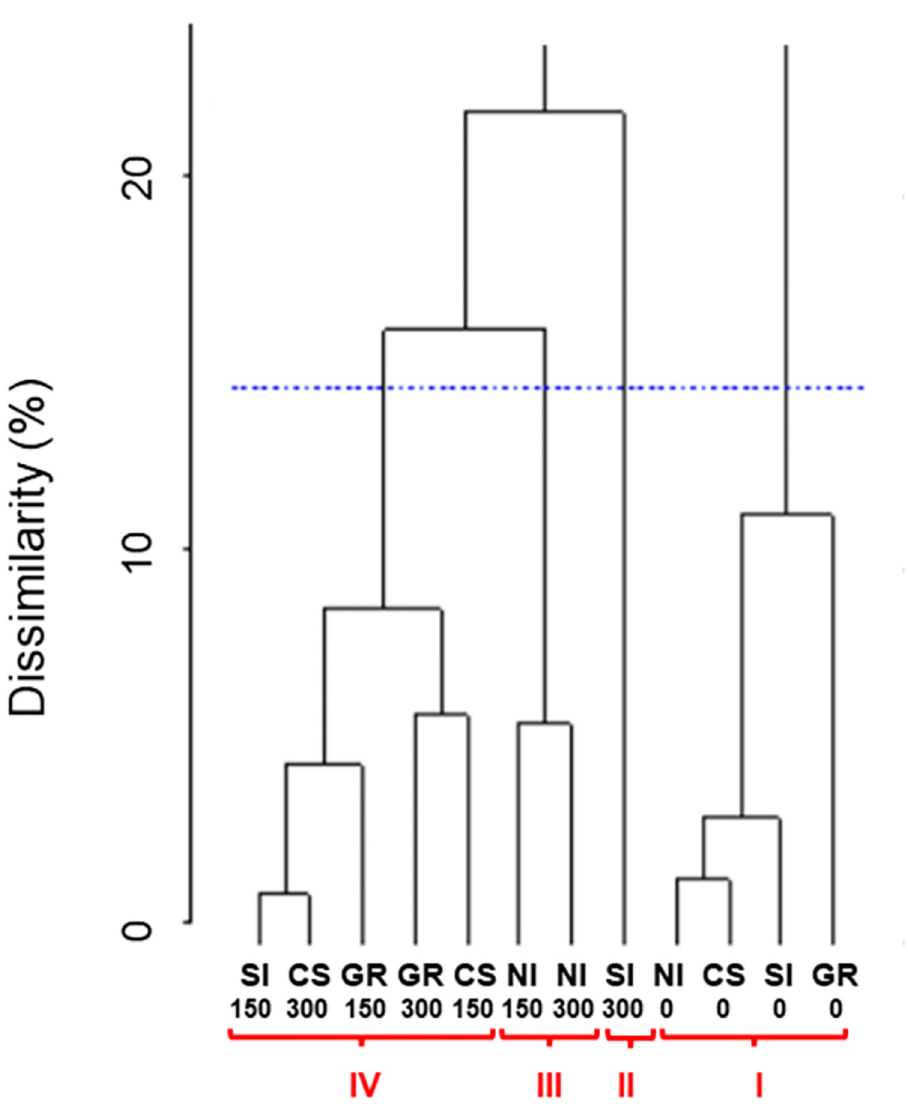
Fig 3. Clustering of combinations of Aspergillus niger FS1 inoculation methods and P doses obtained by the unweighted pair-group method with arithmetic mean (UPGMA) based on Euclidean distance. SI: Seed inoculation, CS: Conidial suspension, GR: Granular formulation, NI: Non-inoculated. P doses: 0, 150, and 300 kg P 2 O 5 ha -1 .